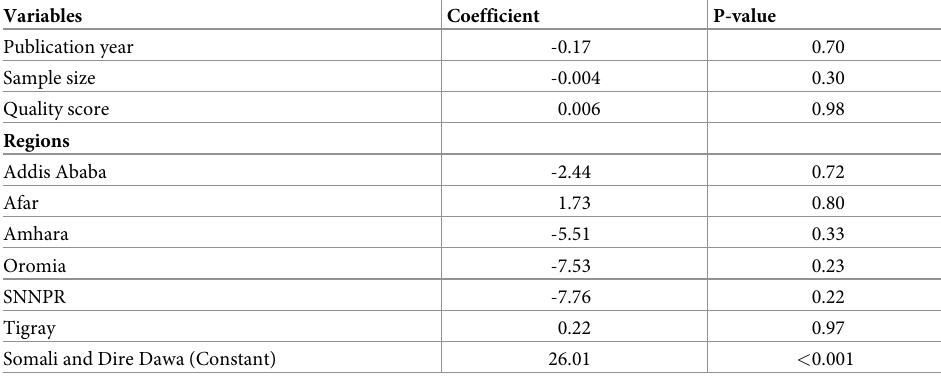
Table 3. Related factors with heterogeneity of diarrheal prevalence among under-five children in the current meta-analysis (based on univariate